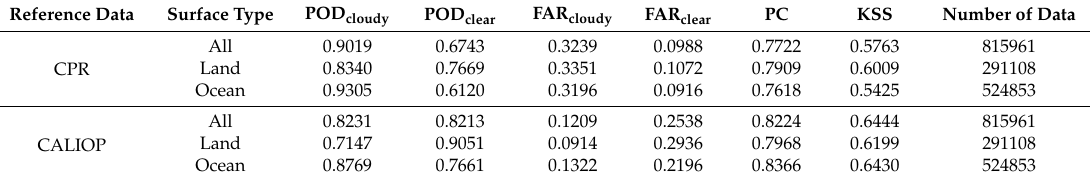
Table 4. Probability of detection (POD), false alarm ratio (FAR), proportion correct (PC), and Kuiper’s skill score (KSS) scores of Spinning Enhanced Visible and Infrared Imager (SEVIRI) cloud detection compared with Cloud Profiling Radar (CPR) and Cloud-Aerosol LiDAR with Orthogonal Polarization (CALIOP) with regard to surface